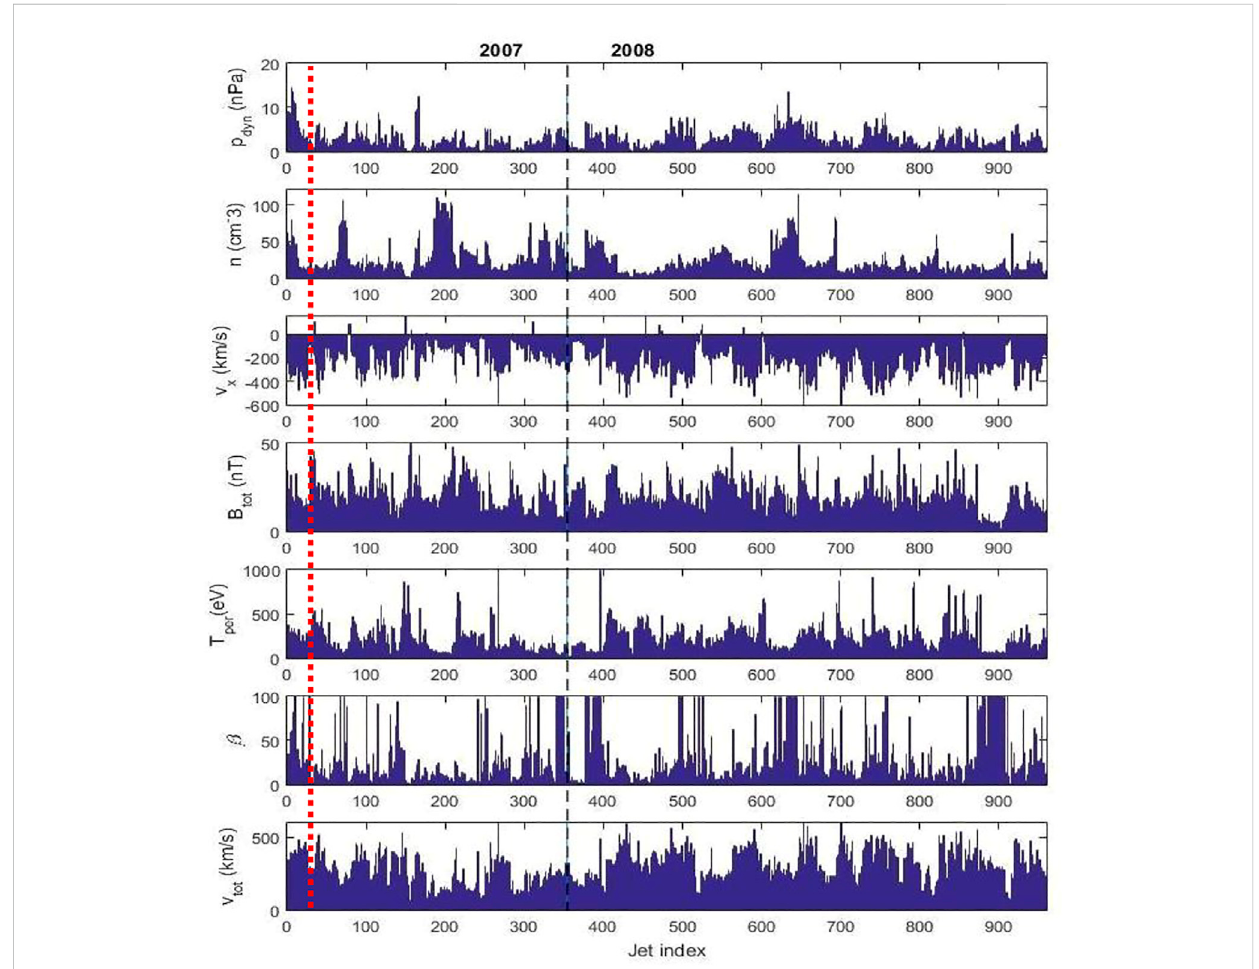
FIGURE 2 A summary of jets ’ properties included in this study. The panels show from top to bottom: the dynamic pressure, p dyn , the plasma density, n, the component of the jet ’ s velocity in GSE x direction, v x , the magnetic fi eld intensity, B tot , the perpendicular ion temperature, T perp , the total plasma beta, β , andthebulkspeed, v tot .Onlyonemeasurementperjetisshown,theoneatthemomentwhenthejet ’ sdynamicpressureismaximum.Thereddashedred line indicates the two jets presented in detail in Figure